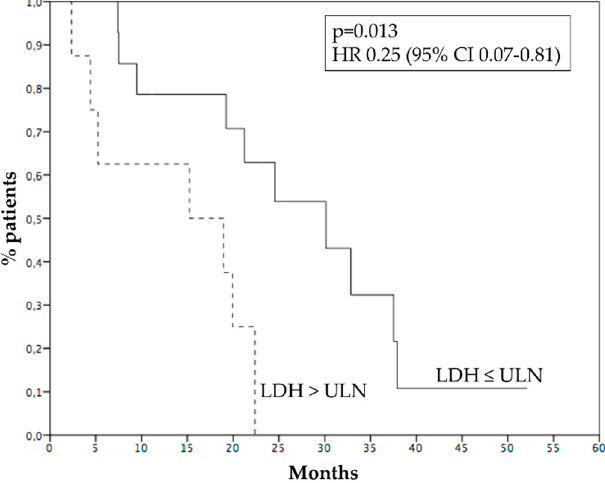
Figure 6. Survival according to basal LDH: normal (30.1 months, solid line) or higher than ULN